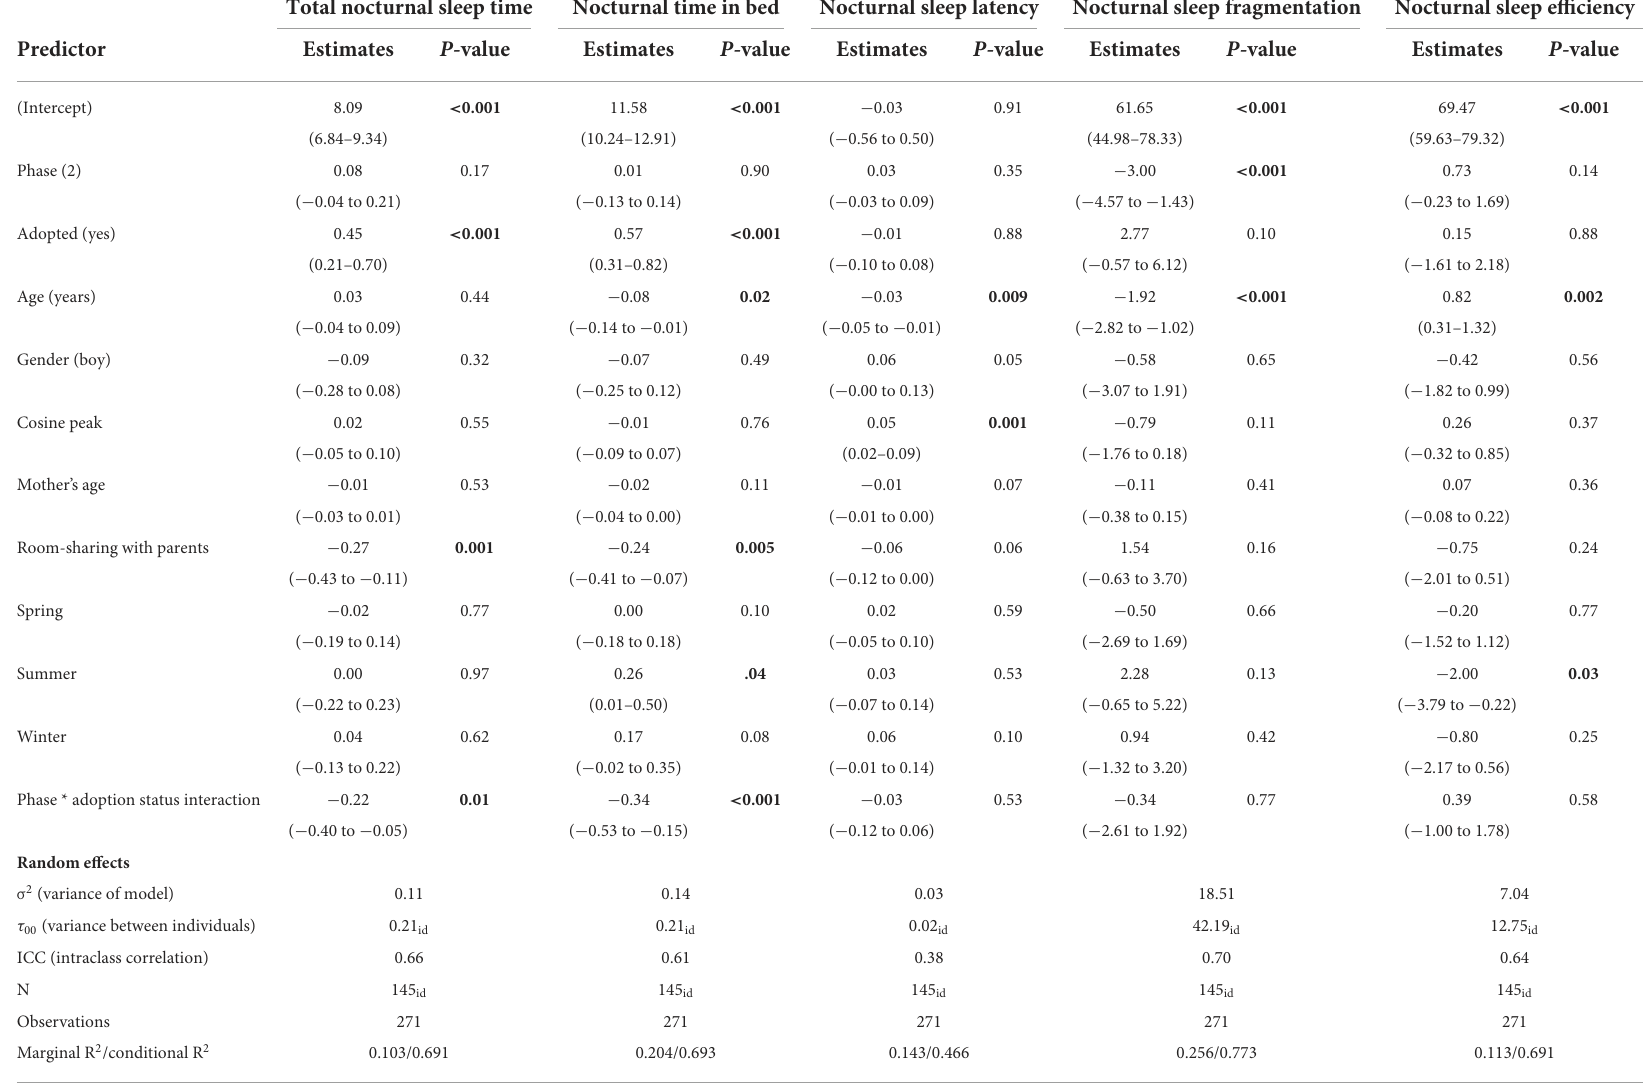
TABLE 3 Associations between adoption status and changes in nighttime sleep over the study